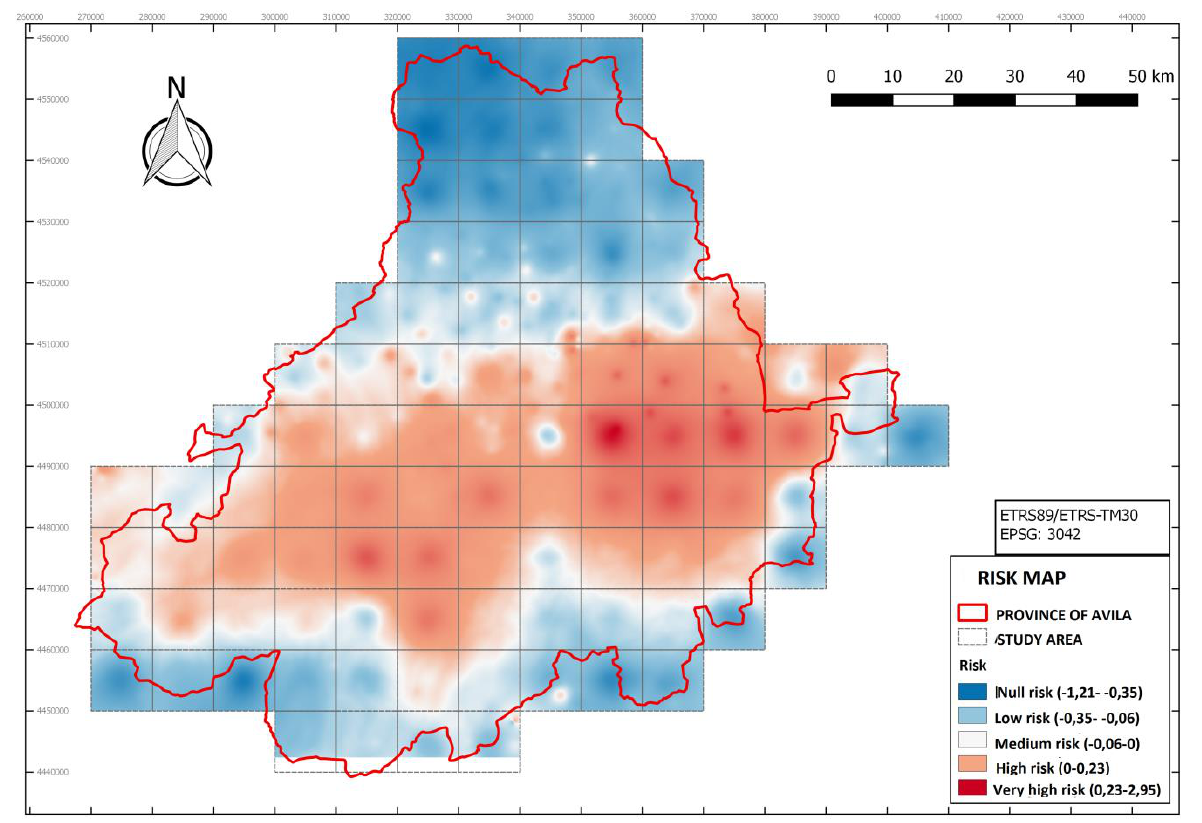
Figure 4. Attack risk map of the study area. Source: own development based on the methodology of stages 1, 2, and 3